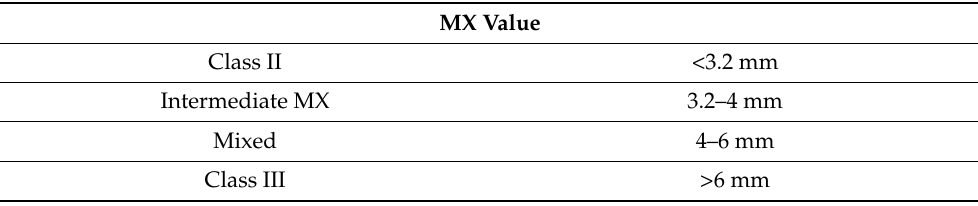
Table 8. Identification of intervals regarding the spatial evaluation of the mandible with respect to the plane coursing the Anterior Nasal Spine (ANS). This spatial value is defined as Mandible (MB).